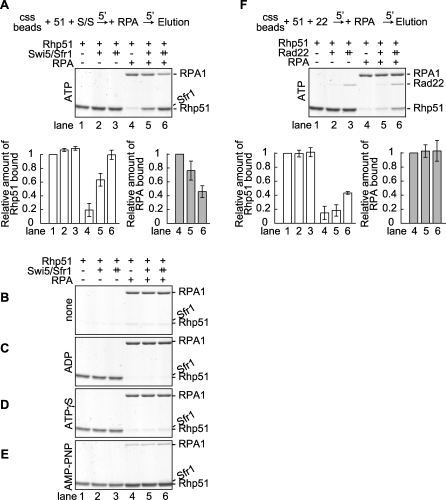
Swi5-Sfr1 Activates the Rhp51 Filament in an ATP-Dependent MannerThe css beads were mixed with 5 μM Rhp51 in the presence or absence of mediators at 37 °C for 5 min, followed by the addition of RPA. After incubation at 37 °C for 5 min, proteins bound to the beads were pulled down and analyzed by SDS-PAGE.(A) Upper panel, SDS-PAGE gel of the pulled down samples in the presence of ATP. Lower panel, graphs showing the amounts of Rhp51 (51) and RPA bound to ssDNA, determined from their band intensities in the gel. S/S, Swi5-Sfr1.(B) Rhp51 cannot bind to ssDNA in the absence of adenine nucleotide.(C) In the presence of ADP, Rhp51 binds to ssDNA, but RPA displaces Rhp51 from ssDNA, even in the presence of Swi5-Sfr1.(D) In the presence of ATPγS, the results are similar to those obtained with ADP.(E) In the presence of AMP-PNP, Rhp51 binds to ssDNA as in the presence of other nucleotides (lanes 1–3). Even in the absence of Swi5-Sfr1, Rhp51 is resistant to the RPA challenge (lane 4).(F) An experiment similar to (A) was performed with Rad22 (22) instead of Swi5-Sfr1.The values and error bars in the graphs in (A) and (F) are average percentages and s.d., respectively, obtained from three independent experiments. (A–F), the plus sign (+) indicates the presence of Rhp51 (51; 5 μM), Swi5-Sfr1 (0.1 μM), RPA (1 μM), and Rad22 (0.1 μM), and each double plus sign (++) indicates both Swi5-Sfr1 (0.25 μM) and Rad22 (0.25 μM).